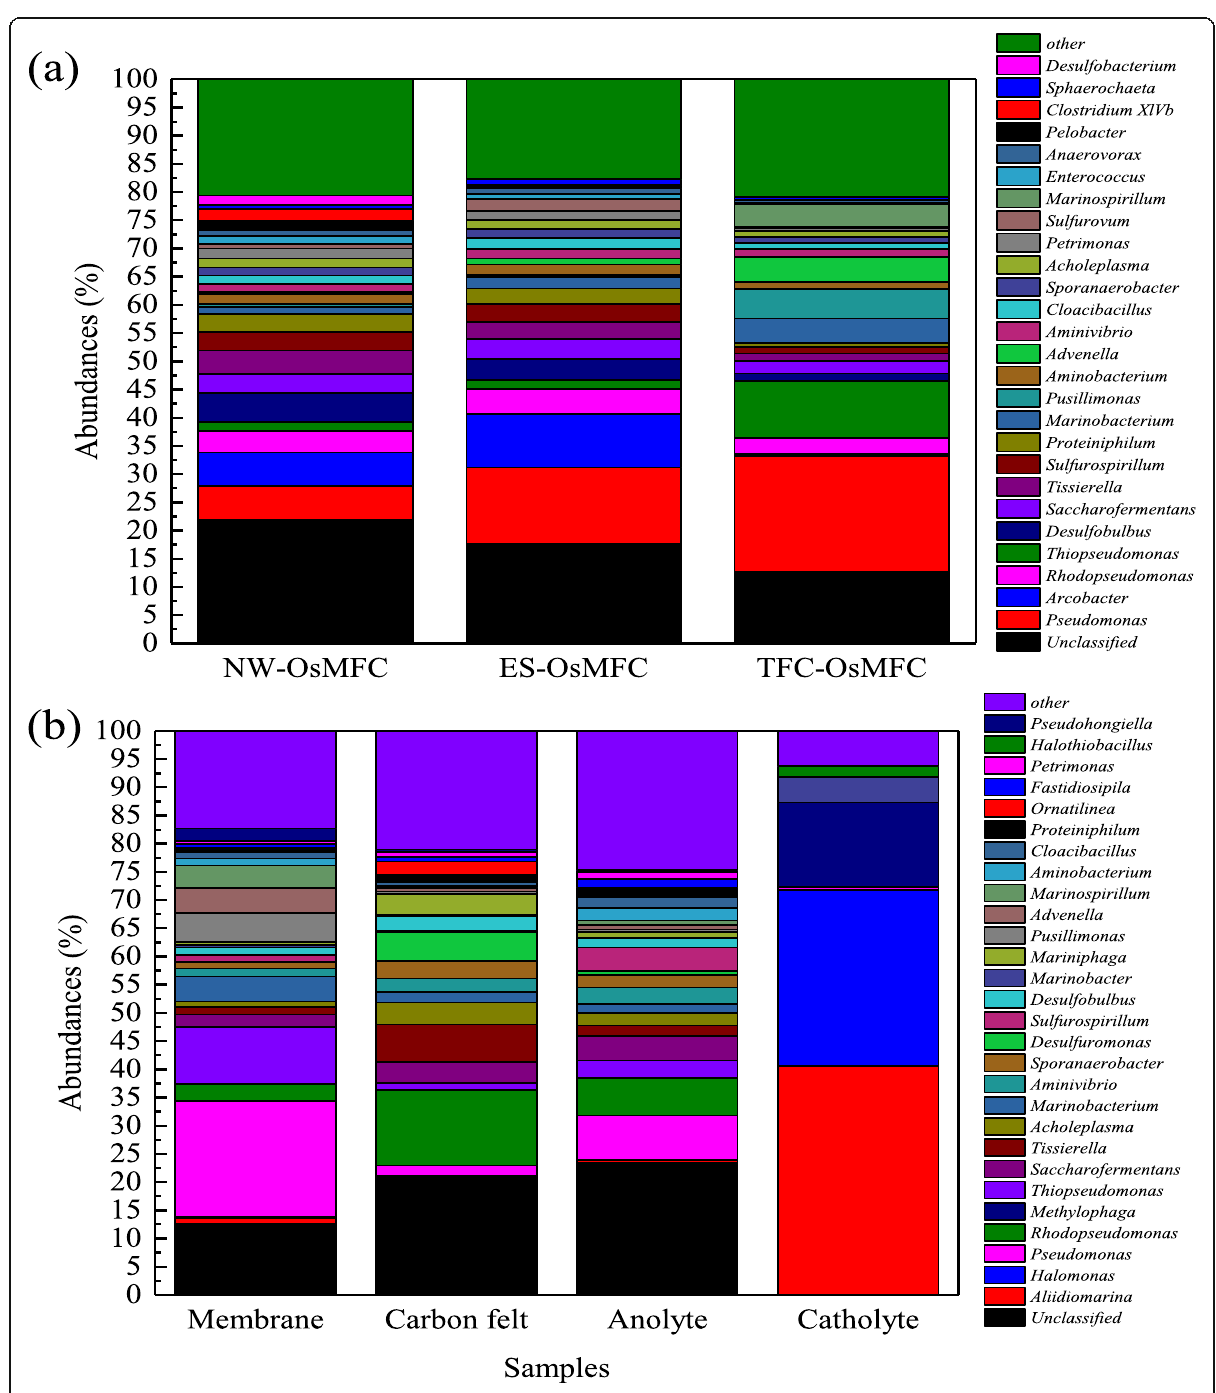
Fig. 5 Distribution of microorganisms in each sample of different OsMFCs ( a ), different site ( b ) at Genus